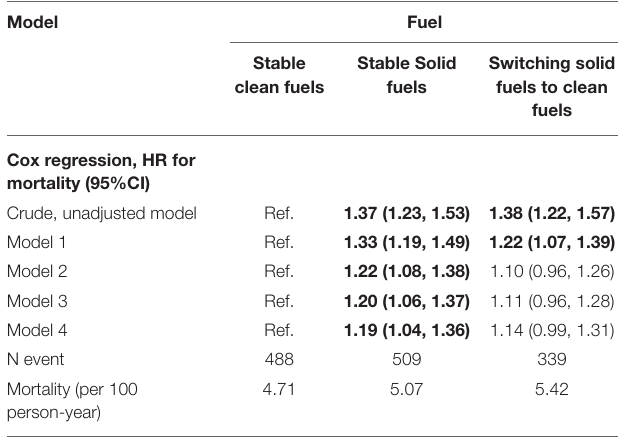
drinking, dietary diversity score, BMI, marital status, social activity and education; Model 3: further adjusted income, PM 2.5 and city population; Model 4: further adjusted IADL, ADL, MMSE and chronic disease. Bold represents p <